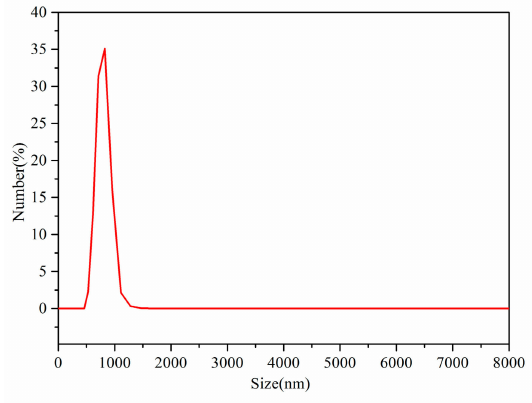
Figure 3. Size distribution of large silica nanoparticles.